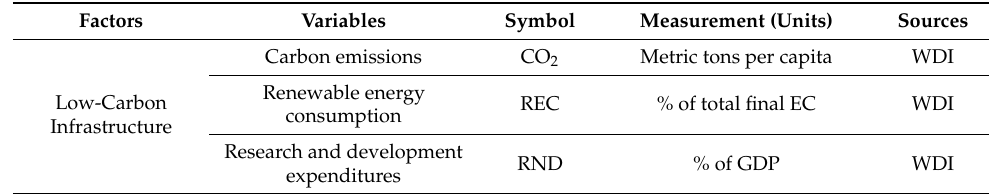
Table 1. List of Variables and